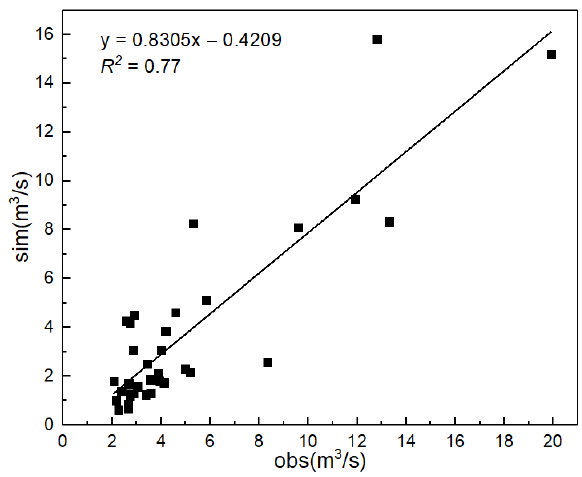
Figure 4. Comparison between simulated values and runoff peak observed at Tianshui station.